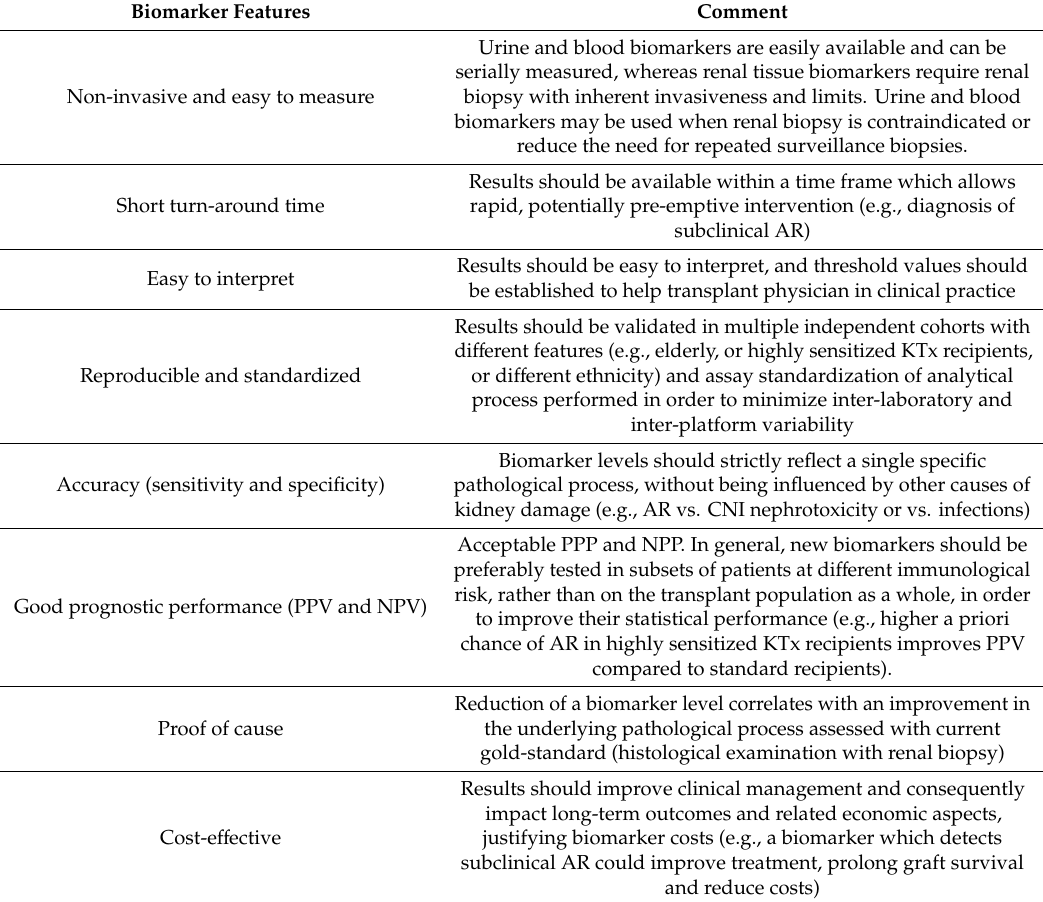
Table 11. Features of an ideal biomarker for kidney transplant (KTx)